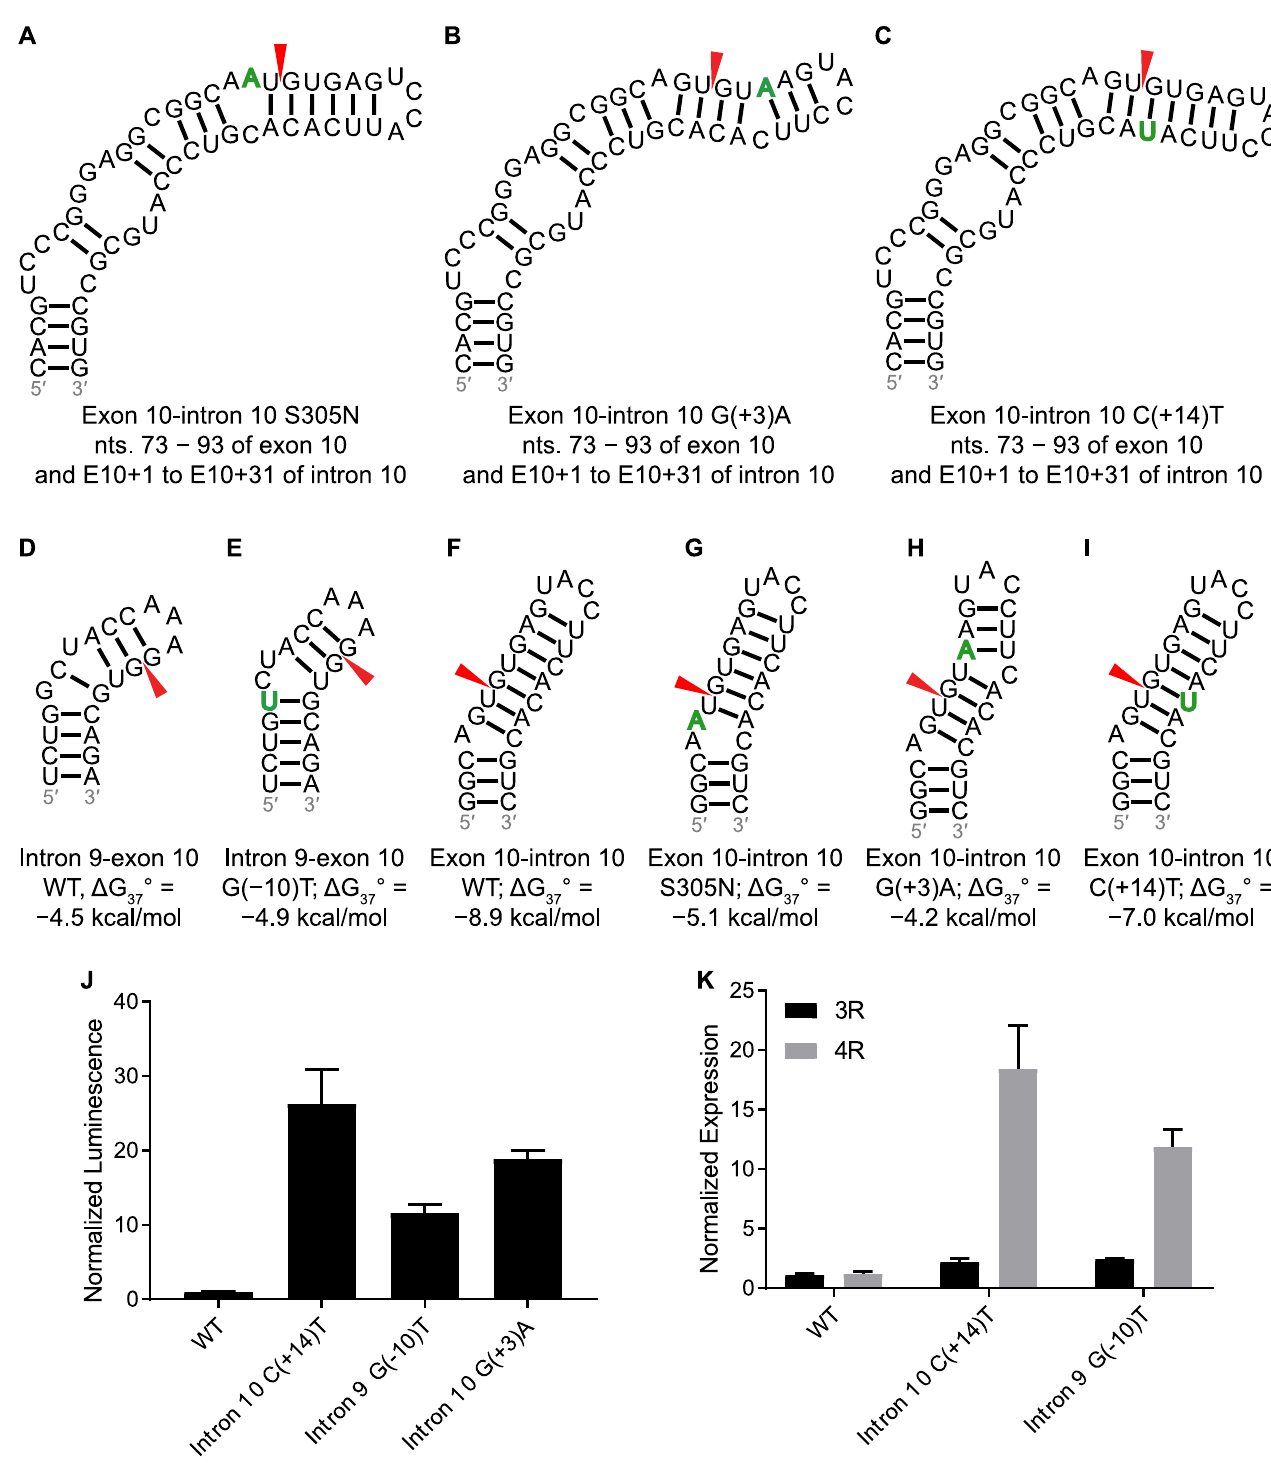
Fig 4. Predicted structures at exon-intron junctions that contain mutations and experimental results with minigenes at exon-intron junctions. Shown are structures containing mutations that affect the wild type structure. Mutations are denoted in green. Splice sites are denoted with red arrowheads. (a) to (c) Extended structures of hairpins at the exon 10-intron 10 junction containing S305N, G(+3)A , and C(+14)T mutations, respectively. (d) and (e) Wild type and G(−10)T mutant hairpin structures, respectively, at the intron 9-exon 10 junction. (f) to (i) Minimal wild type and mutant S305N, G(+3)A , and C (+14)T hairpin structures, respectively, at the exon 10-intron 10 junction. (j) Effect of mutations at the 5 0 and 3 0 splice sites of exon 10 on luciferase activity in transfected HeLa cells. (k) Effect of mutations at the 5 0 and 3 0 splice sites of exon 10 on 3R and 4R tau mRNA levels in HeLa cells as measured by RT-qPCR.